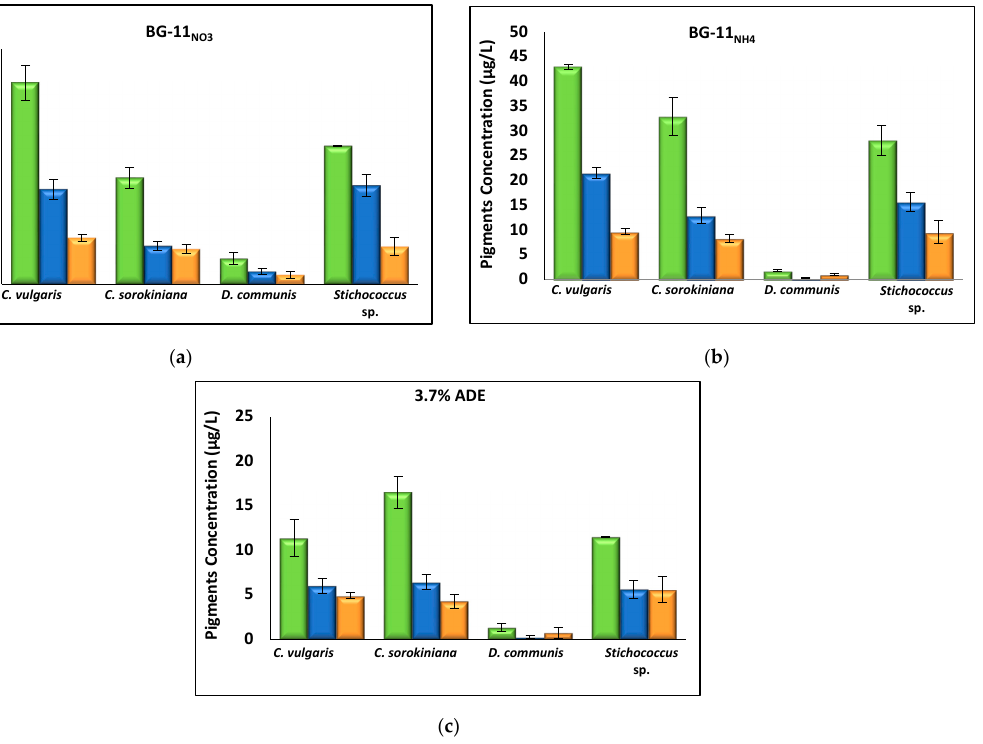
Figure 3. Pigment concentration at the end of the culture period (17th day) of the four microalgae species in the three different media ( a - c ): green bar: Chlorophyll a , blue bar: Chlorophyll b orange bar: Carotenoids.